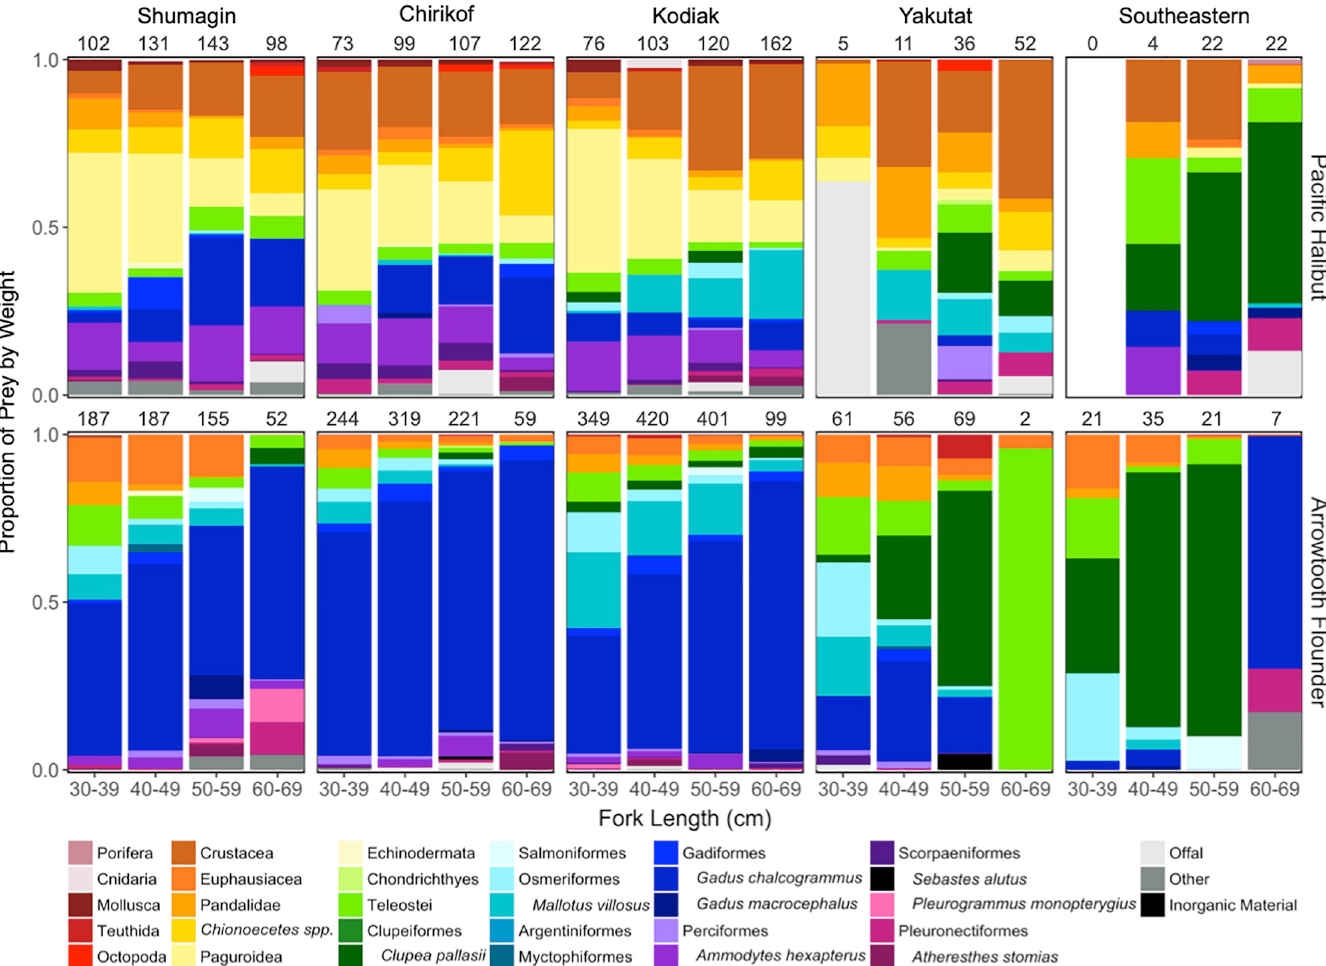
Fig 5. Mean proportions of prey by weight for Pacific Halibut and Arrowtooth Flounder (all survey stations, 1990 to 2013). Calculations were grouped by International North Pacific Fisheries Commission (INPFC) statistical area and size class. Sample sizes are indicated above each stacked bar. Prey taxa that constituted less than 0.01 by weight were classified into broader taxonomic groups ( e . g ., phyla for invertebrate taxa and order for fishes). https://doi.org/10.1371/journal.pone.0209402.g005 PLOS ONE | https://doi.org/10.1371/journal.pone.0209402 December18,